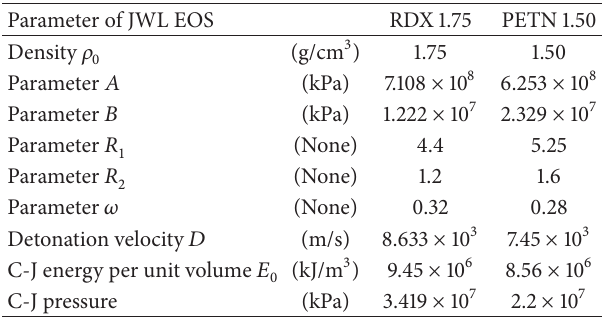
Table 2: Material properties of high explosives (RDX 1.75, PETN 1.50).